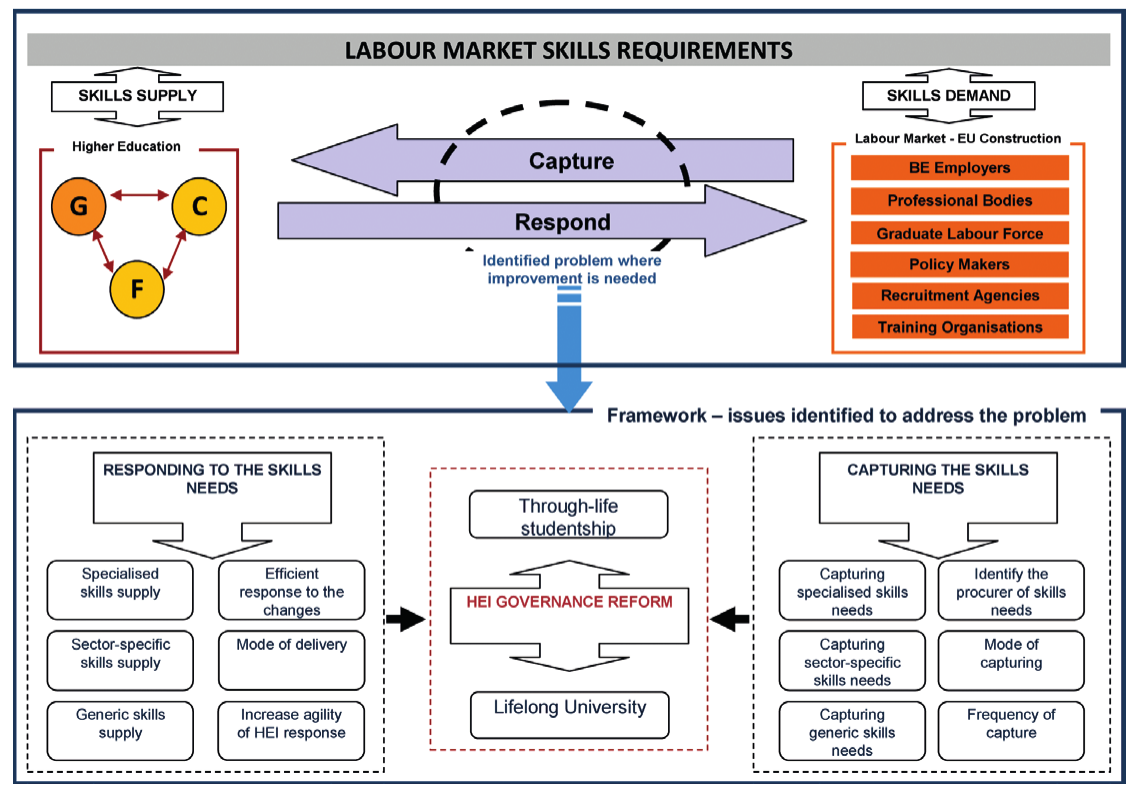
Figure 1. Initial conceptual